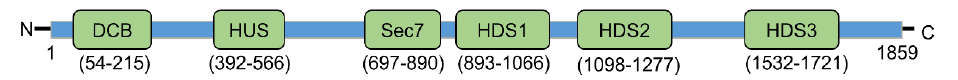
Figure 3. Domain organization of GBF1. The positions of the Sec7, DCB, HUS, and HDS1-3 domains are indicated. The amino acid residues comprised in each domain are shown in parentheses.